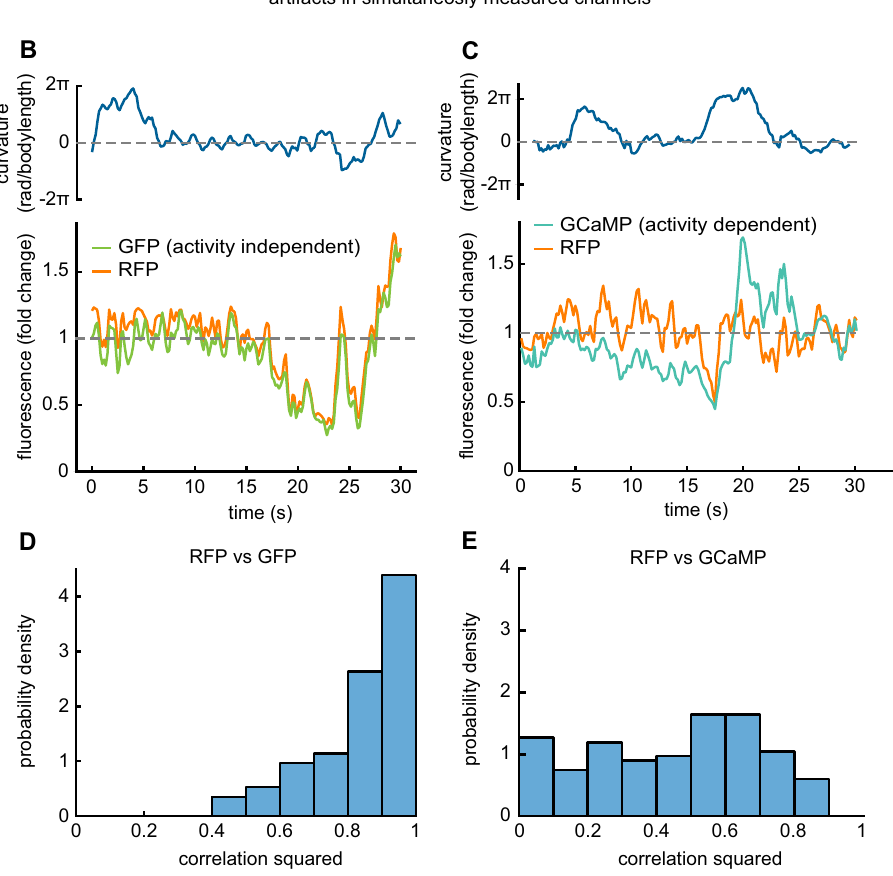
Fig 1. Behavior induces motion artifacts in optical recordings. A) Diagram of a moving C . elegans undergoing motion and deformation during simultaneous measurements of GCaMP and RFP fluorescence. Deformations of the cell can conspire with imperfect segmentation to create motion artifacts. RFP intensity fluctuations reflect motion or noise. GCaMP intensity fluctuations reflect motion, calcium activity, and noise. B) Top , Animal body curvature. Bottom fluorescence of a neuron from a whole-brain recording of a moving worm expressing both GFP and RFP. Both fluorophores are activity-independent, yet we observe large highly correlated fluctuations in the two-channel fluorescence. C) Top , Body curvature. Bottom , fluorescence of a single neuron taken from a whole-brain recording in a moving worm expressing both GCaMP and RFP. The two channels still show correlated fluctuations despite the activity dependence of GCaMP. D) Histogram of the Pearson correlation coefficient squared between the red and the green channel for a dataset of whole-brain recordings from 10 moving GFP, RFP control worms. E) Same as D but in 9 GCaMP, RFP